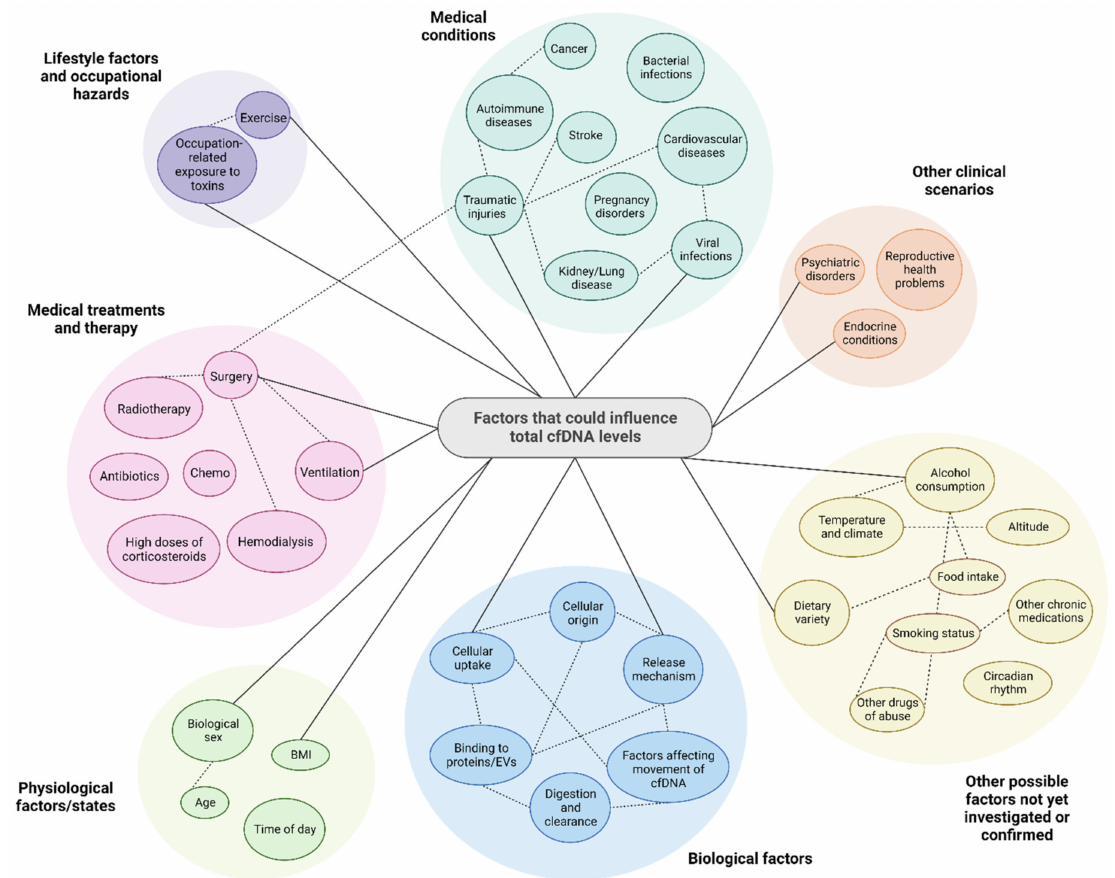
Figure 3. Factors that can potentially affect total cfDNA levels. Here we summarize the wide-ranging factors that have been experimentally shown to modulate total cfDNA levels. We also show several other factors that possibly affect total cfDNA levels, but which have not yet been conclusively demonstrated or have not yet been investigated. This makes it very difficult to correlate total cfDNA levels with a specific factor and limits the clinical use of total cfDNA